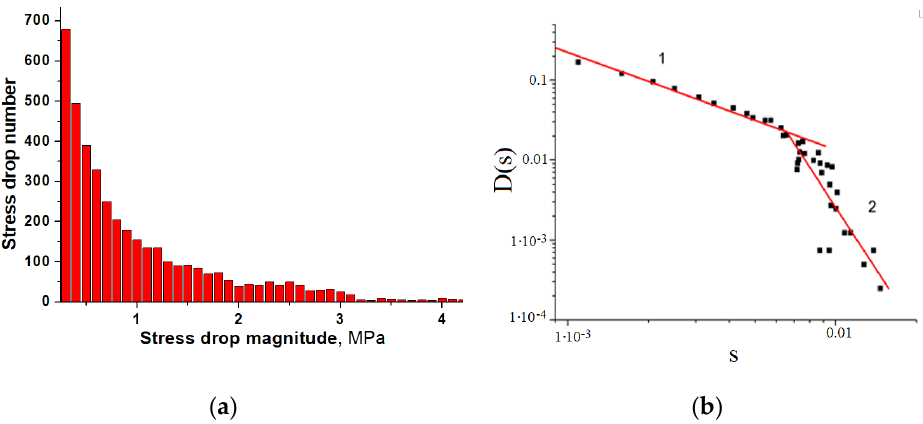
Figure 6. ( a ) Statistical distribution of the number of stress drops; ( b ) statistical distribution function D ( S ) of the normalized stress drop amplitudes in double logarithmic coordinates.